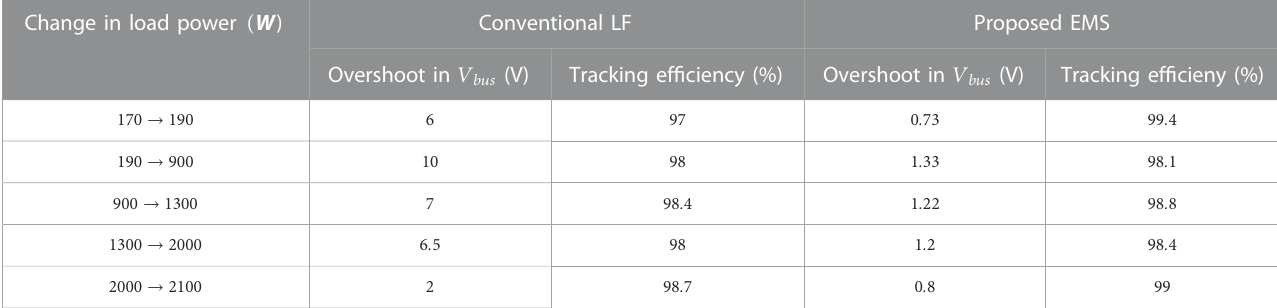
TABLE 4 Comparison between the proposed EMS and the conventional LF method under different load conditions. Change in load power ( W